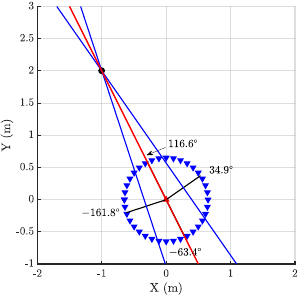
Figure 1. Different positions represented of antenna 2 marked with triangles ( (cid:72) ) when turned around the fixed antenna 1 ( (cid:78)